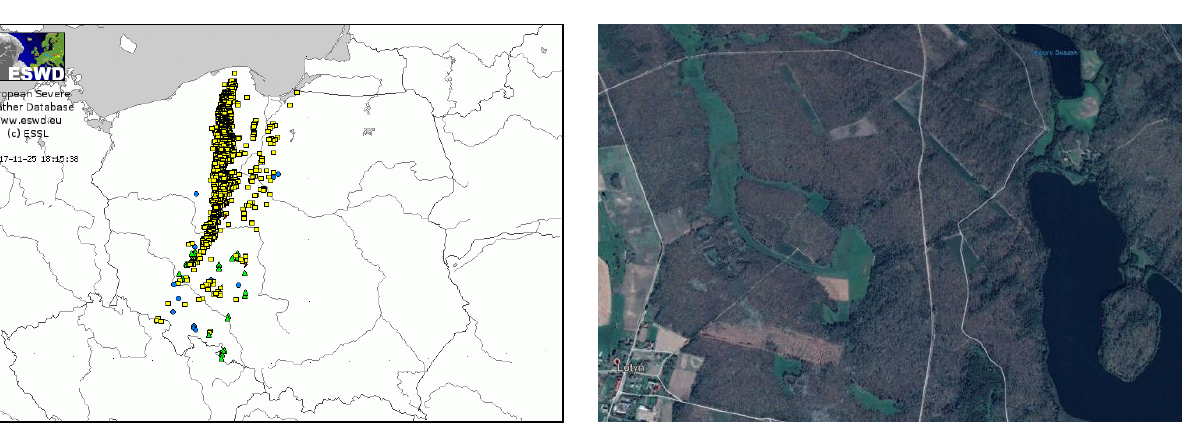
Fig. 6. Aerial photograph of the large areas with destroyed forest near Rytel. Source: Google Earth